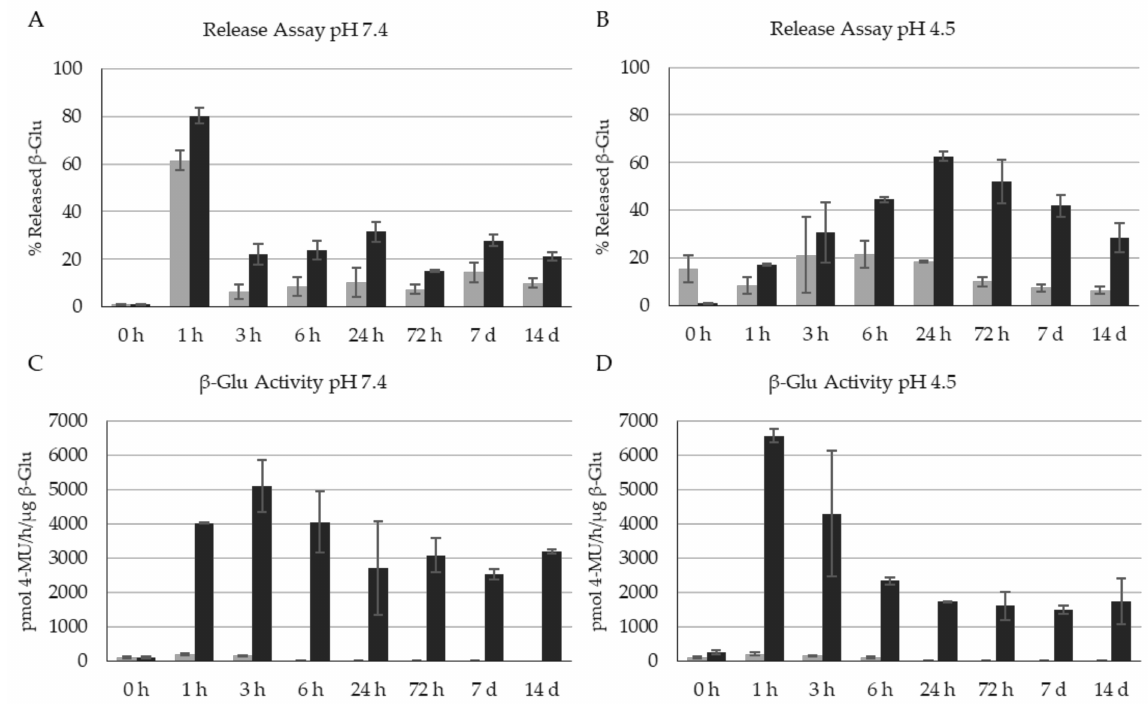
Figure 5. Quantification of the release and enzyme activity of β -glucosidase from the nanoparticles. Grey: control Solution 0 NPs (no Tween ® 20). Black: Solution 4 NPs (with Tween ® 20). ( A ) %Release of β -Glu at pH 7.4, ( B ) %Release of β -Glu at pH 4.5, ( C ) Activity of released β -Glu at pH 7.4, ( D ) Activity of released β -Glu at pH 4.5. Analysis of N = 3 separate NP